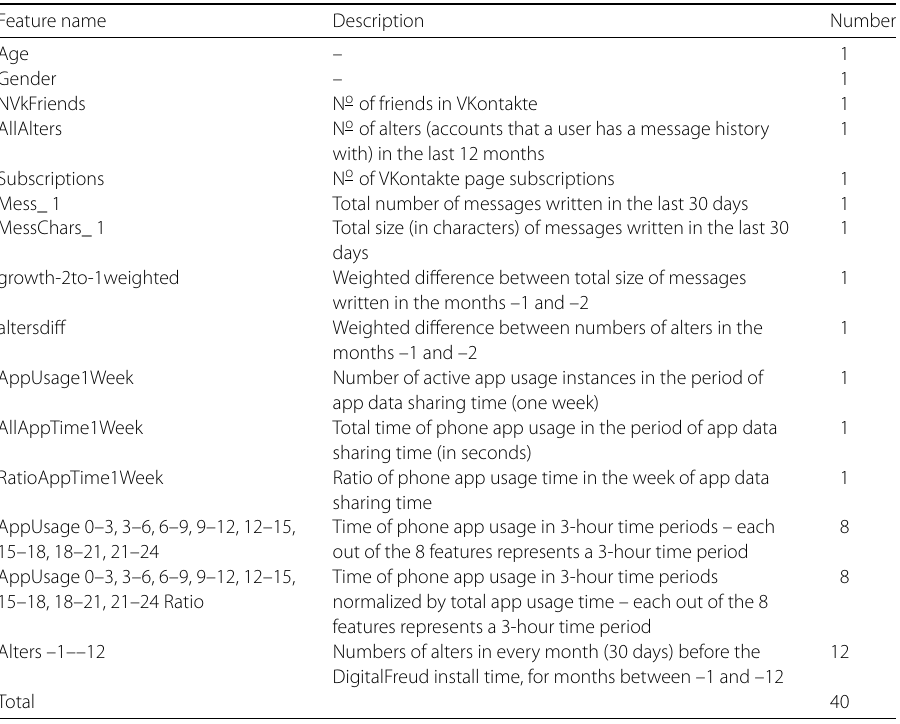
Table 4 User metadata and overall activity